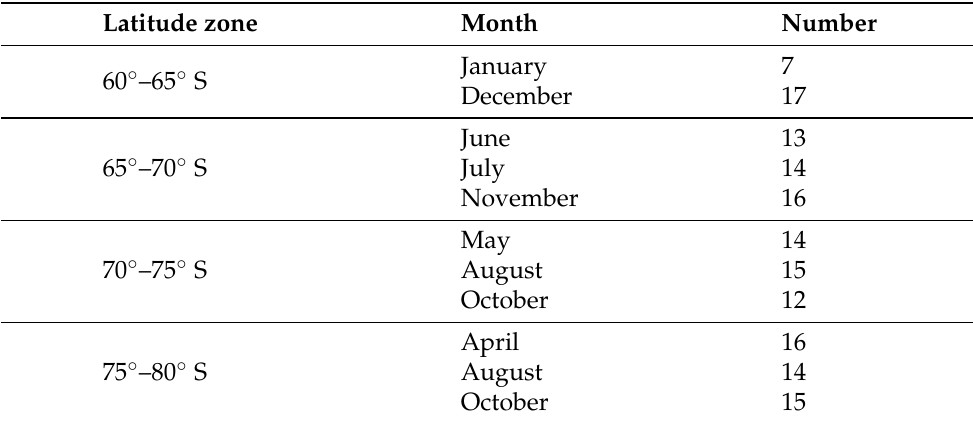
Table 1. Information about the AIUS measurements.